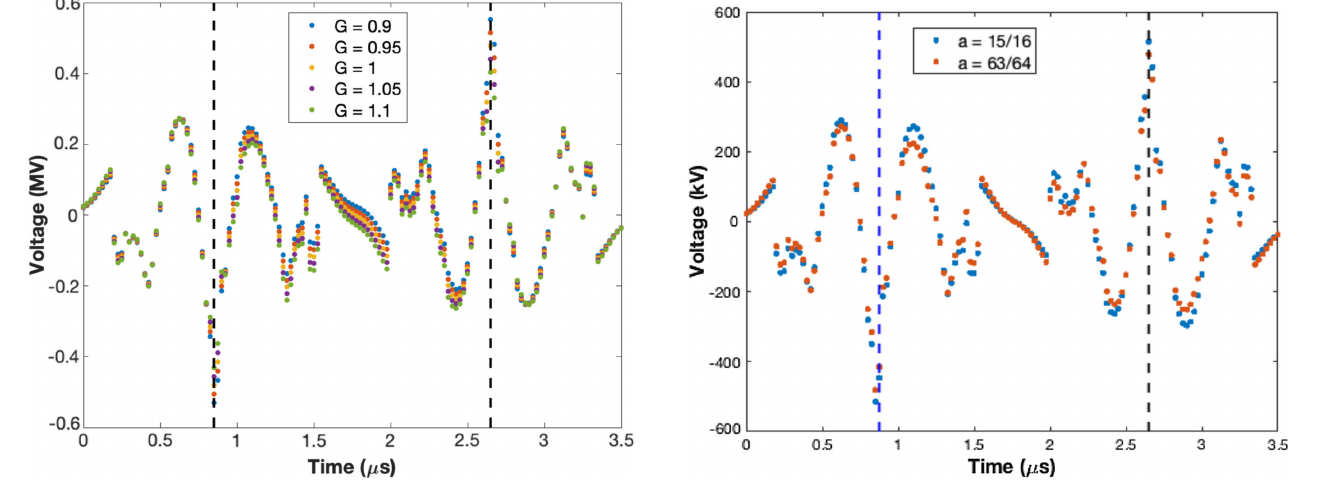
FIG. 12. Uncompensated beam loading for different OTFB bandwidth/gain and ideal feedforward. The batch is indicated with vertical dashed